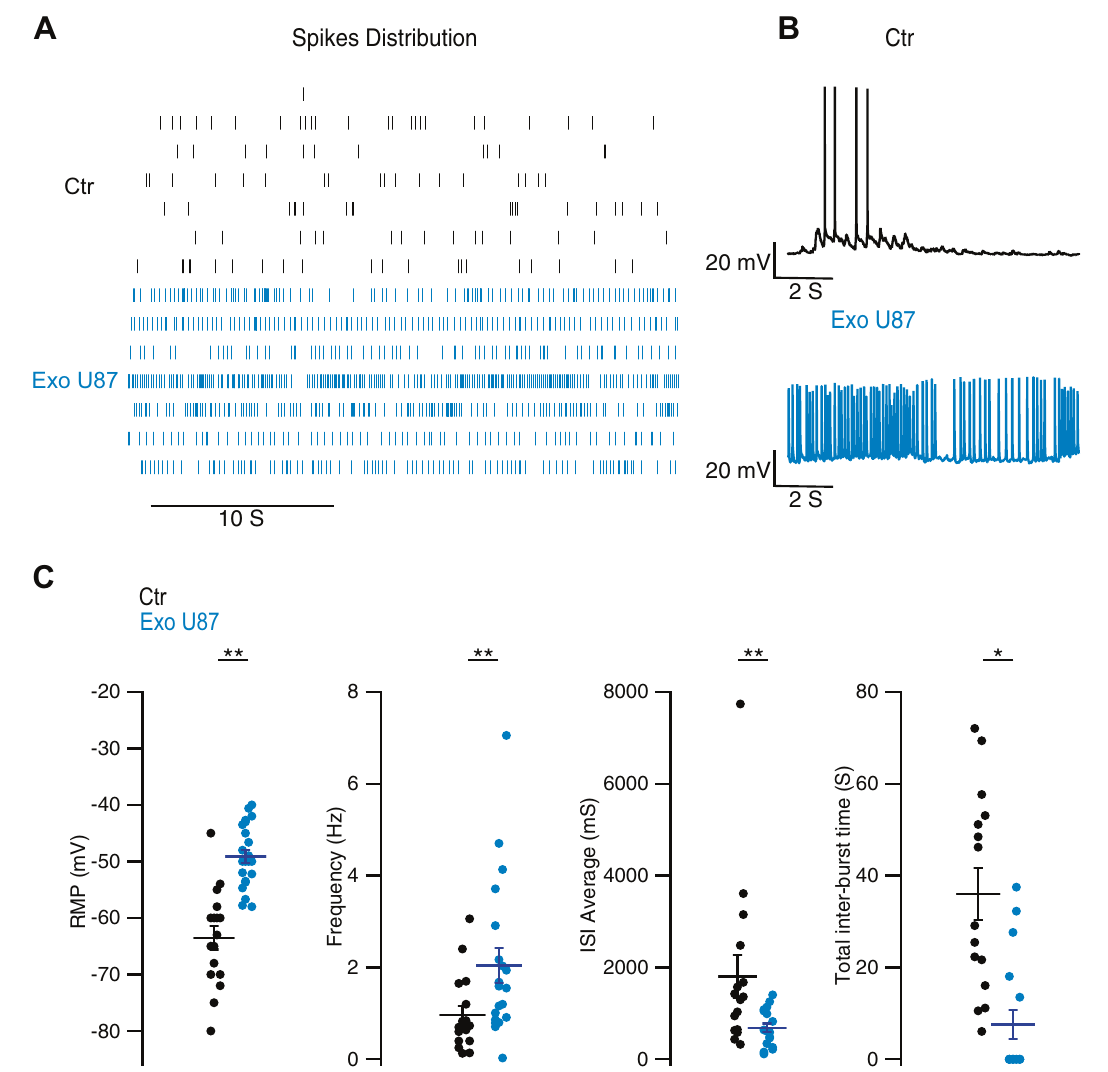
Fig. 3 Glioma cells-derived exosomes increase spontaneous and evoked neuronal excitability. Spontaneous activity of hippocampal neurons was recorded in current clamp for 4 min in control neurons (ctrl) and in cultures treated for 24 h with U87-derived exosomes (U87). A Representative pattern of activity in a 30 s window is shown as a scatter plot (Black: Control n = 7, Blue: U87 treated n = 7) and B representative traces of single neurons in 10 s. Exosome-treated cells show a dense spiking activity that was absent in control conditions. C Exosome-treated neurons showed a striking switch of RMP to positive values and the induction of a long train of action potentials upon current injection. Resting membrane potential (RMP) was measured in the current clamp modality (current I = 0). Control: − 63.529 ± 2.074 mV, n = 17 cells; U87 treatment: − 49.083 ± 1.123 mV, n = 23 cells. Action potential frequency . Control: 0.9620 ± 0.197 Hz, n = 17 cells; U87 treatment: 2.046 ± 0.380 Hz, n = 23 cells. Average inter-spike-interval (ISI) . Control: 1806.49 ± 461.01 ms, n = 16 cells; U87 treatment: 683.68 ± 99.169 ms, n = 17 cells. Total inter-burst time . Control: 36.013 ± 5.678 s, n = 16 cells; U87 treatment: 7.586 ± 3.174 s, n = 17 cells. Data are shown as average ± standard error, signi fi cant differences were assessed with the Wilcoxon – Mann – Whitney U test. ** p < 0.01; * p <